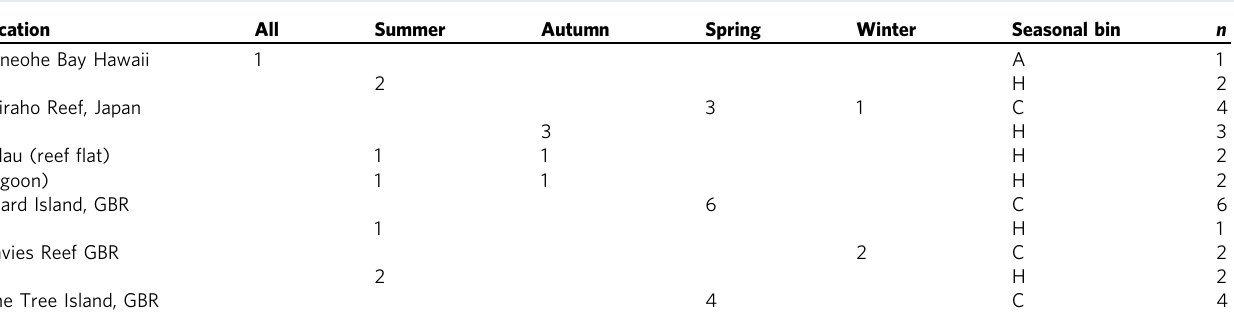
Table 1 Breakdown of repeated measures surveys ( n = 29) used by Davis, et al. 3 to project global declines in G net when accounting for the season and seasonal bins (H hot, C cold, A all, GBR Great Barrier Reef). Location All